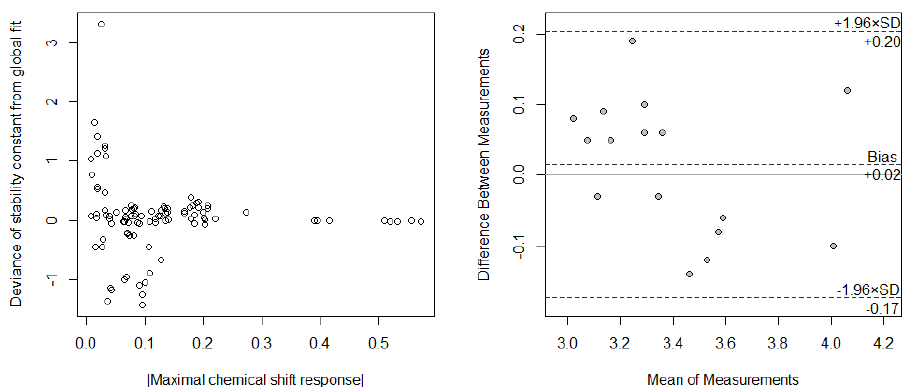
Figure 6. Left: The deviance of each log K obtained from single NMR signals from its concomitant globally fit log K as a function of absolute maximal chemical shift response. Right: The Bland–Altman plot of the complex stability constants for CyD-fenbufen and CyD-fenoprofen complexes obtained with two methods: CD and 1 H NMR spectroscopy.